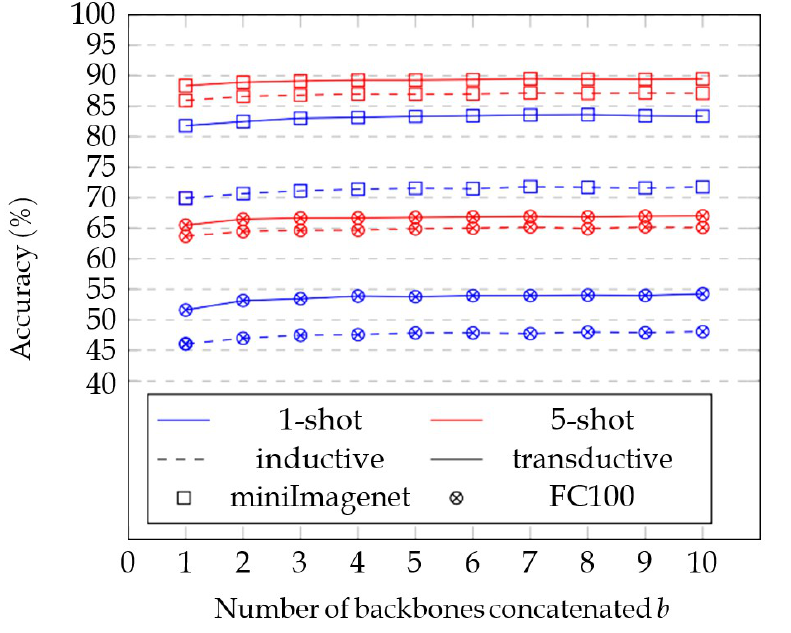
Figure A3. Ablation study of the number of backbones; we performed 10 5 runs for each value of b